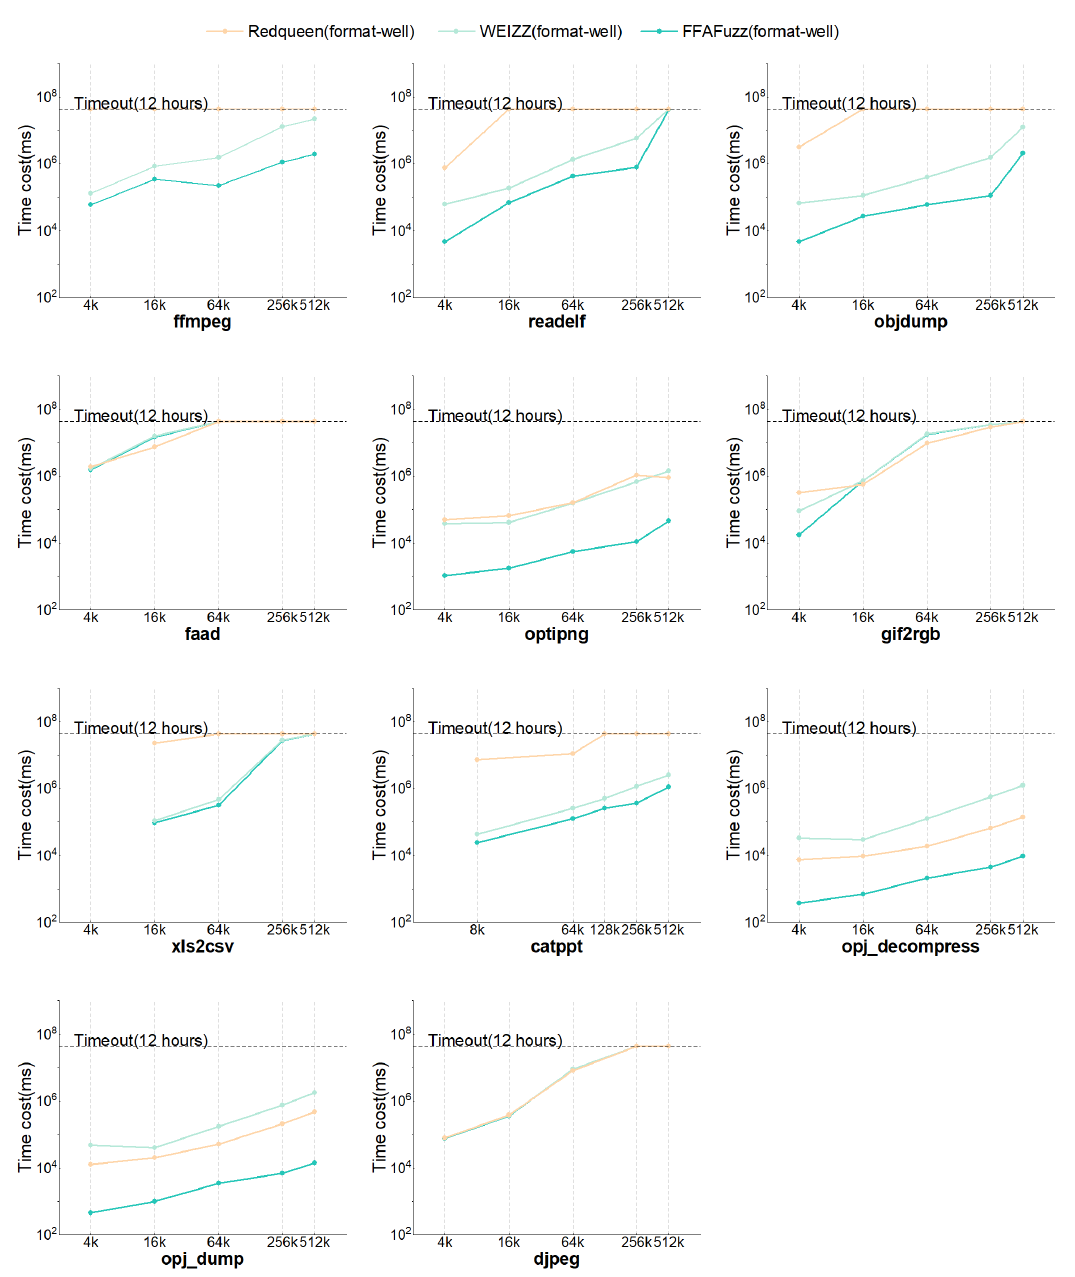
Figure A2. The time costs over the 11 targets of each compared fuzzer input with format-well as the initial